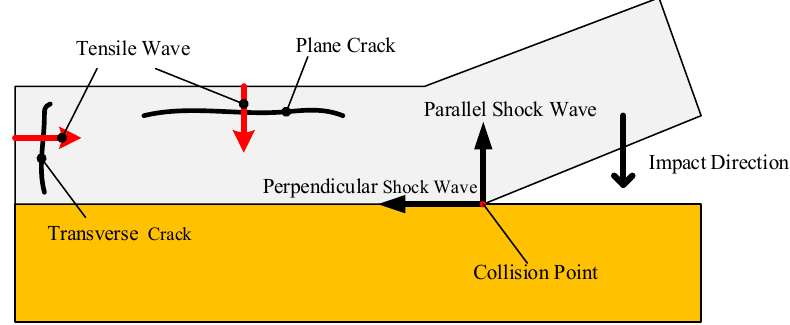
Figure 7. Schematic illustration of crack formation during collision.